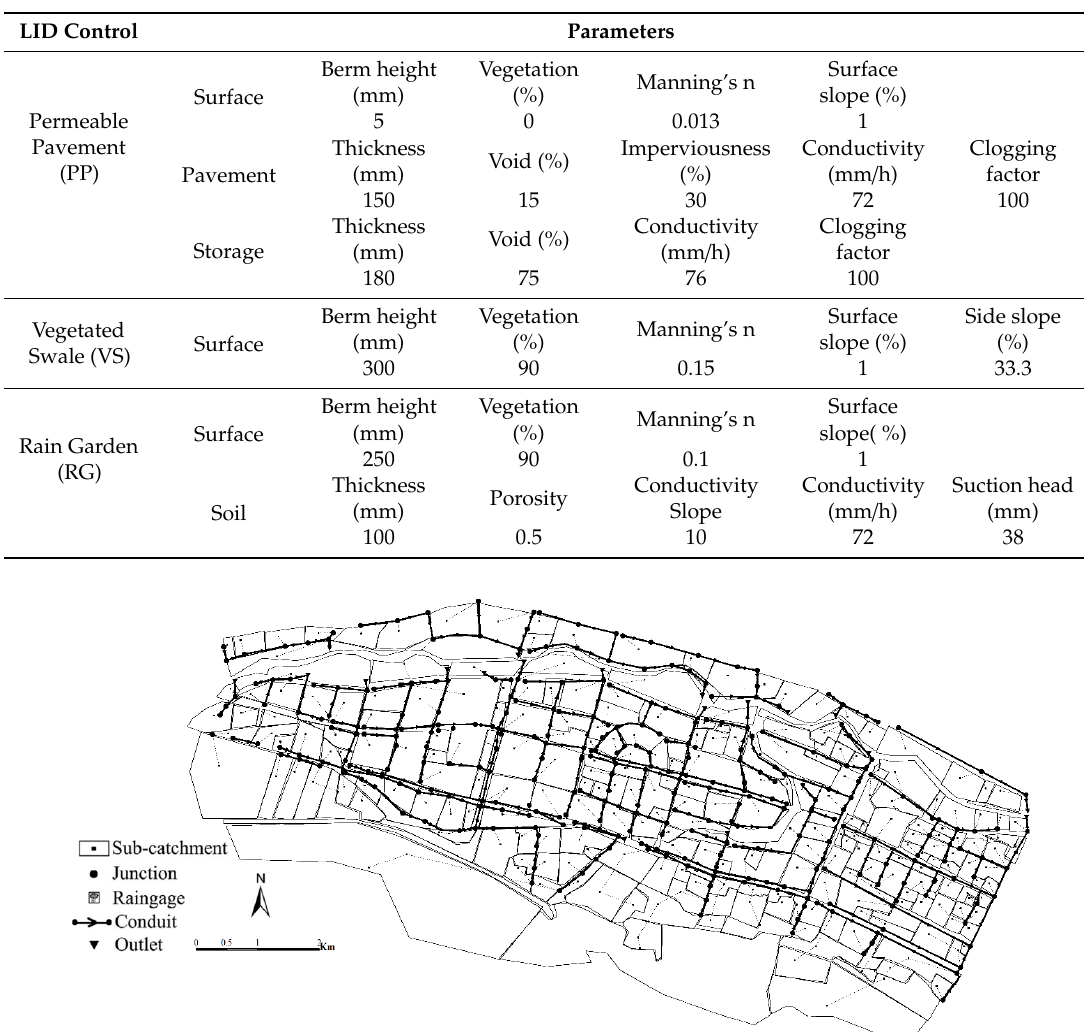
Table 3. Values of LID controls parameters.